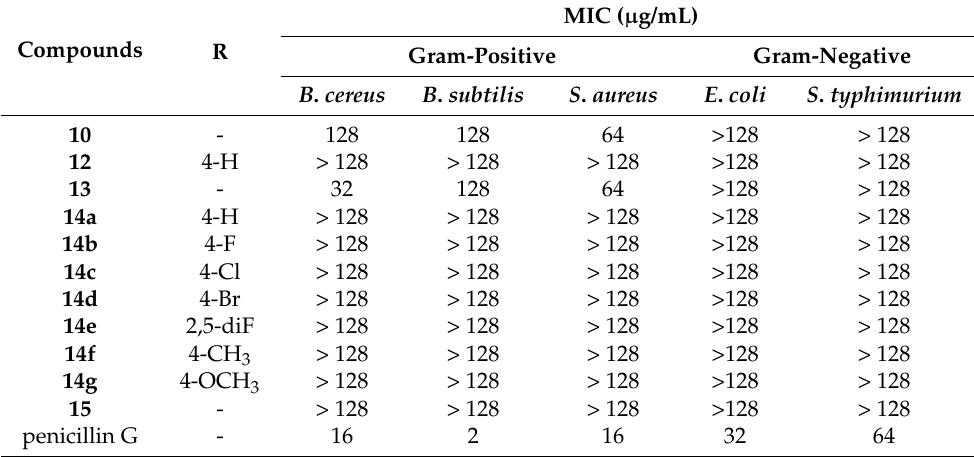
Table 1. MIC of coumarin derivatives 10 , 12a , 13 , 14a – g , 15 and penicillin G against B. cereus , B. subtilis , S. aureus , E. coli , S. typhimurium